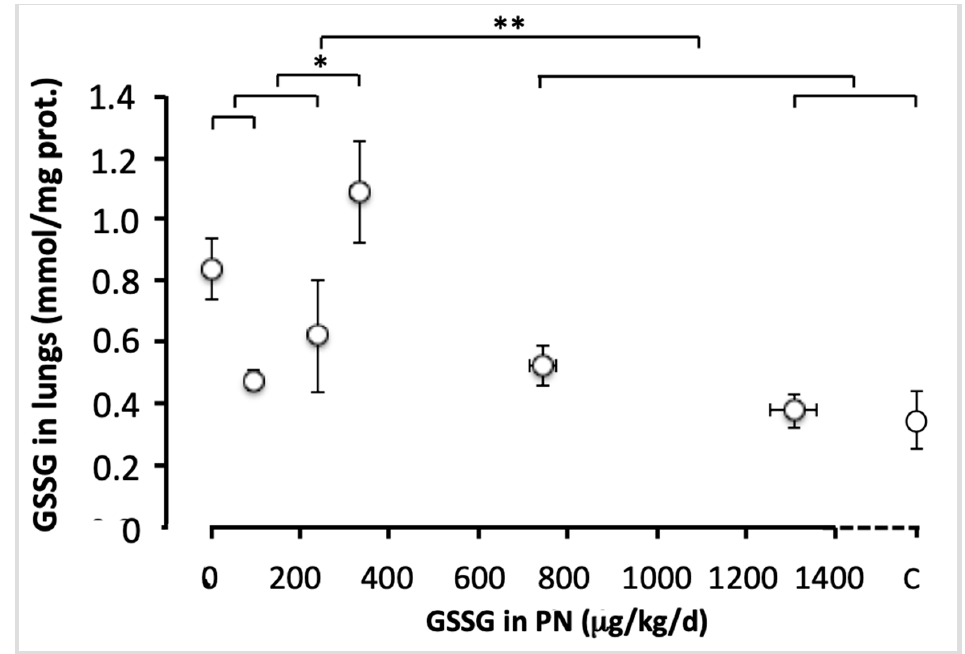
Figure 4. Pulmonary GSSG levels as a function of increasing doses of GSSG added to PN. The control (C) value was added to the abscissa after the highest dose of GSSG. The orthogonal comparisons were 0 vs. 95 µg/kg/d (no statistical difference: p < 0.07), both vs. 240 µg/kg/d (no difference). The first three doses were different from 330 µg/kg/day (F (1.49) = 5.77; p < 0.05). Among the highest doses, 1300 µg/kg/d were not statistically different from the control, both were not different from 750 µg/kg/d. The highest doses (750 to 1300 µg/kg/d) and the control were statistically different (F (1.40) = 13.7, p < 0.001) from the lowest doses (0 to 330 µg/kg/j). Mean ± S.E.M. for redox ( y axis) and dose ( x axis). The bars indicate the orthogonal comparisons; the absence of significant difference is shown by the absence of symbol above the bar; *: p < 0.05; **: p < 0.001; n = 6–11 per group. Figure 5 shows representative pictures of a histological preparation for each group